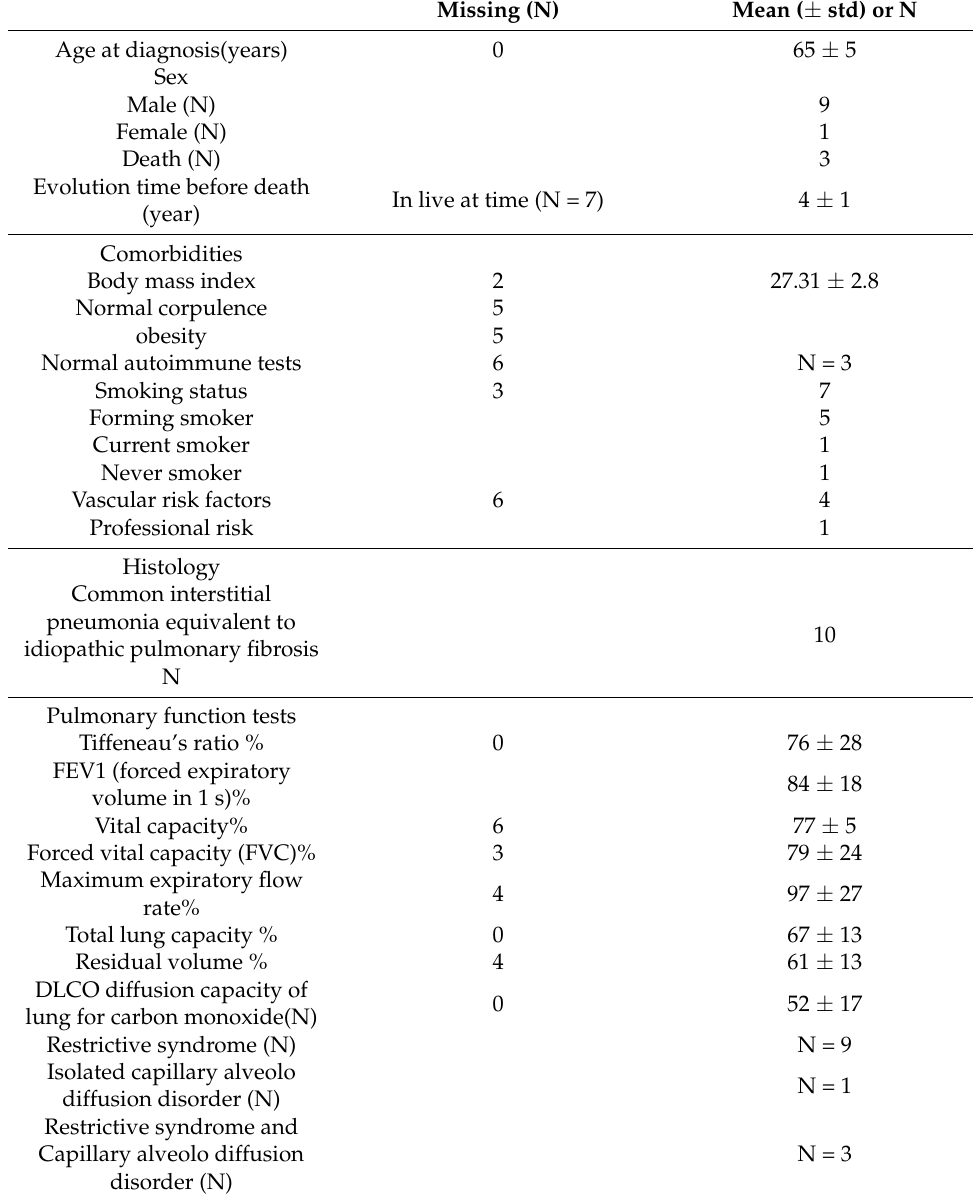
Table 9. Description of the cohort of IPF (N = 10). (N = 10). N corresponds to the number of